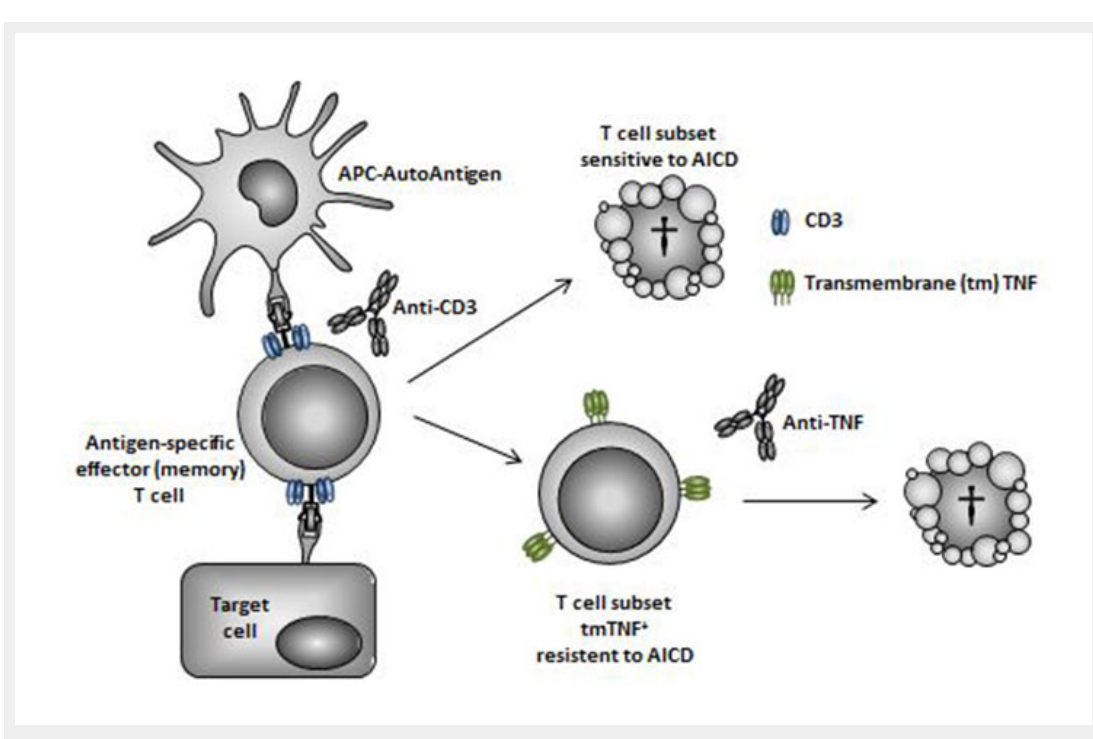
Figure 2 Schematic representation of a possible complementary mechanism of action for anti-CD3 and anti-TNF combination therapy on pathogenic T cells. In response to antigen presentation and exposure to anti-CD3 mAb in the secondary lymphoid and target organs, antigen-specific effector and/or effector memory T cells either undergo apoptosis through the process of activation-induced cell death (AICD) or survive and express several activation markers, including transmembrane (tm) TNF. An anti-TNF mAb can then deplete by ADCC (and/or reverse signalling) pathogenic T cells resistant to anti-CD3 induced